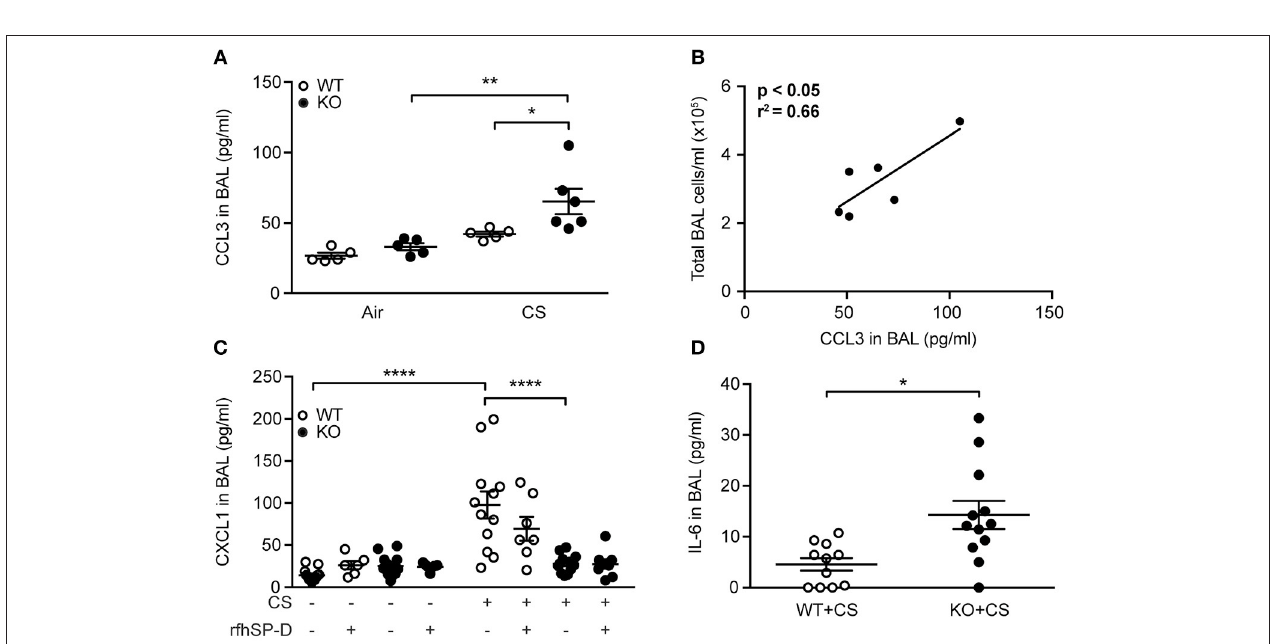
FIGURE 5 | SP-D-dependent regulation of cigarette smoke (CS)-induced pro-inflammatory cytokines in mice. (A) CCL3 levels in bronchoalveolar lavage fluid (BAL) are significantly increased in SP-D-deficient mice compared to WT littermates after subchronic CS exposure. (B) Significant correlation between BAL levels of CCL3 and total BAL cell count in CS-exposed SP-D-deficient mice. (C) SP-D-deficient mice fail to upregulate CXCL1 in BAL after acute CS exposure. (D) BAL levels of IL-6 after acute CS exposure. n = 5–13. * p < 0.05, ** p < 0.01, **** p < 0.0001, analyzed by (A,C) one-way ANOVA followed by Bonferroni’s test or (D) Student’s t